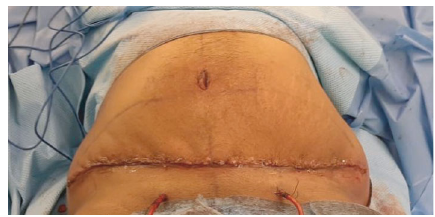
Figure 3: After skin closure.